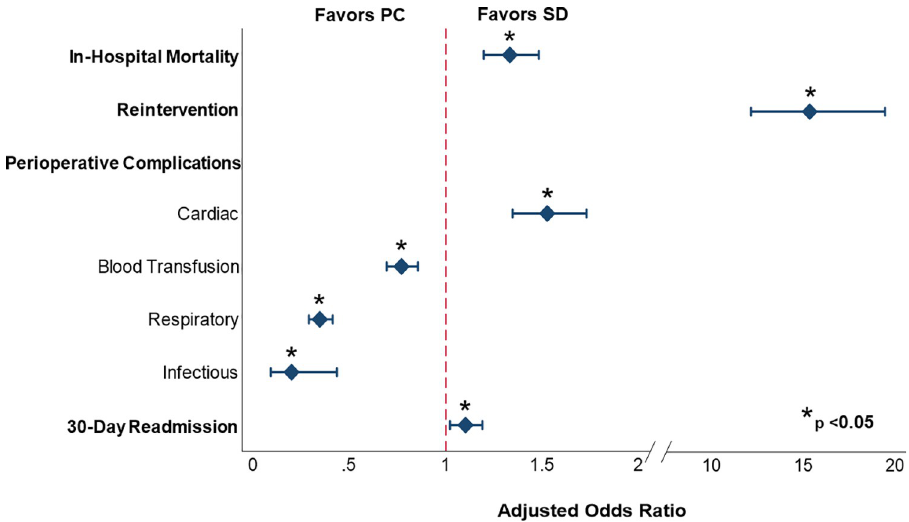
Fig 2. Independent association of pericardiocentesis with select outcomes of interest (Reference: Surgical drainage). Abbreviations: PC , pericardiocentesis; SD , surgical drainage.